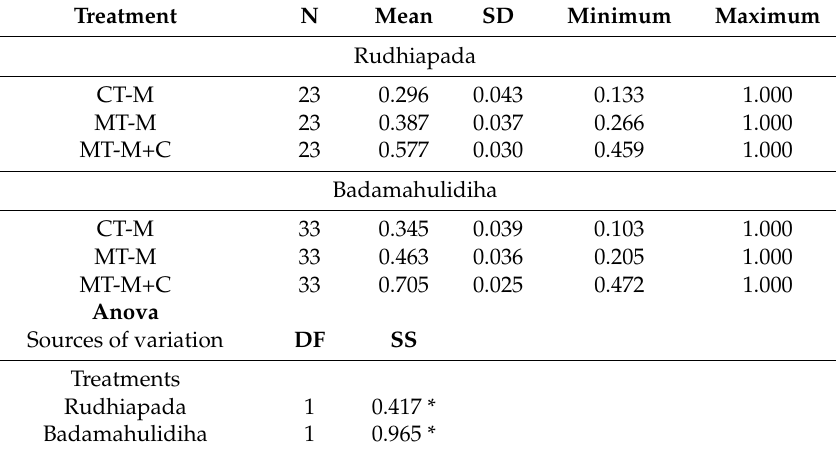
Table 4. VRSTE (variable return to scale technical efficiency) scores and related statistics for smallholder farmers practicing different cropping systems in two villages in Odisha